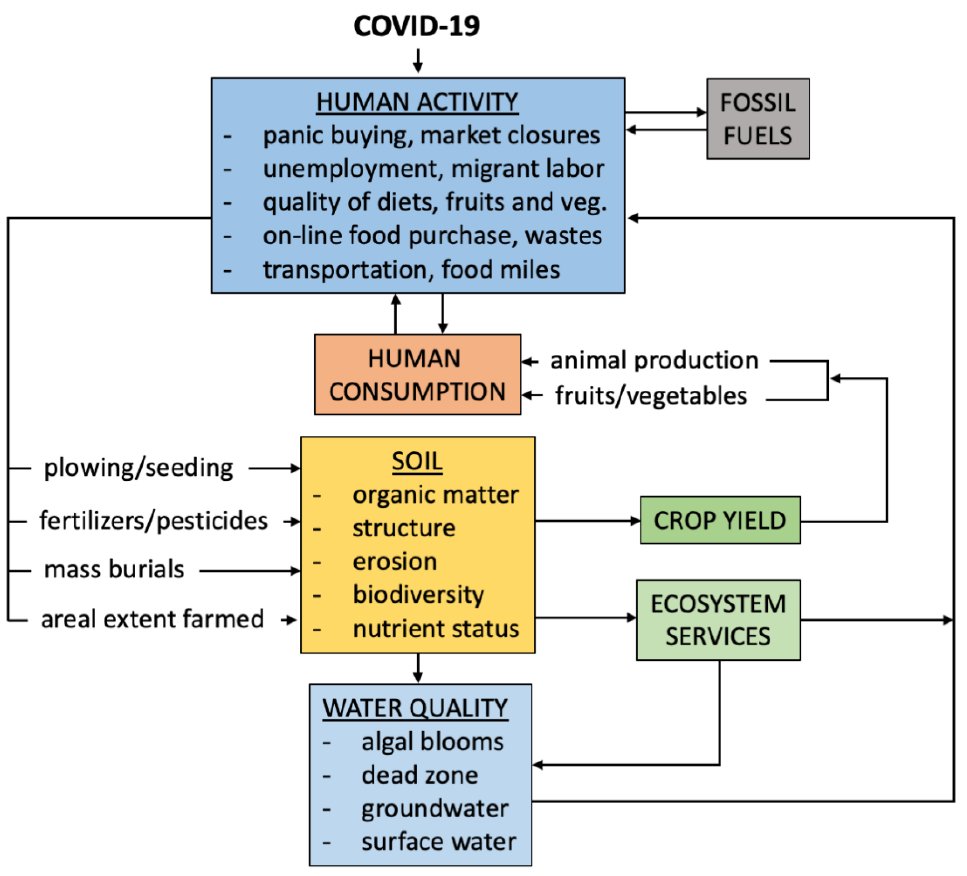
Figure 2. Links and feedbacks illustrating how soil is being impacted by COVID-19.